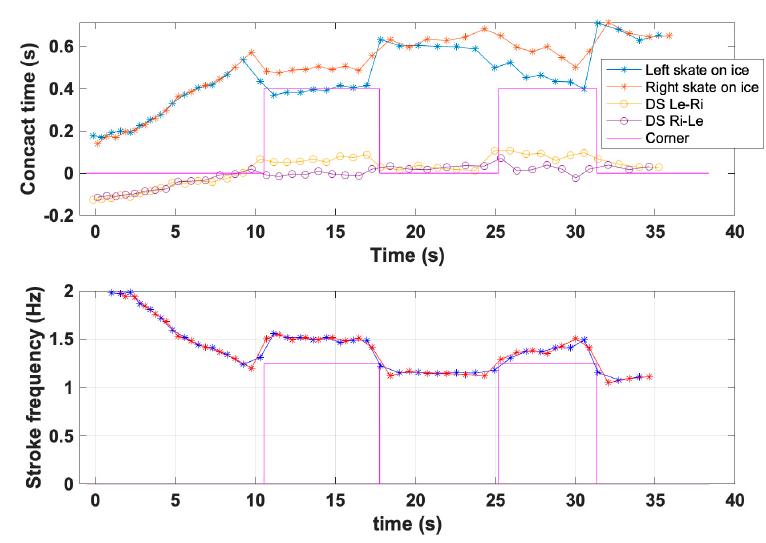
Figure 2. Contact time ( top ) and stroke frequency ( bottom ) on a stroke by stroke basis for a 500 m race of a junior elite speed skater. Blue, left skate; red, right skate.